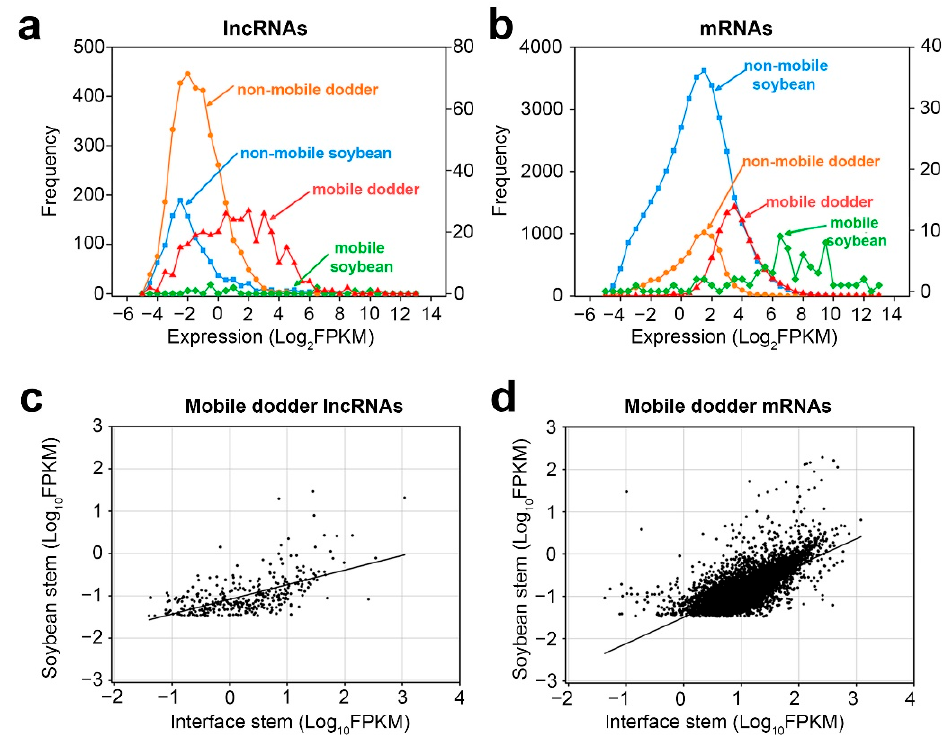
Figure 5. Properties of mobile and non-mobile transcripts: ( a , b ) distribution of lncRNAs ( a ) and mRNAs ( b ) transcript levels in interface stems related to mobility in dodder–soybean associations; ( c , d ) Scatter plots of lncRNAs ( c ) and mRNAs ( d ) transcript levels in the soybean stem versus those in interface stems. A total of 365 dodder lncRNAs were transferred into soybean, whereas 8894 dodder mRNAs were transferred into soybean. Lines correspond to linear regression analysis of the data.